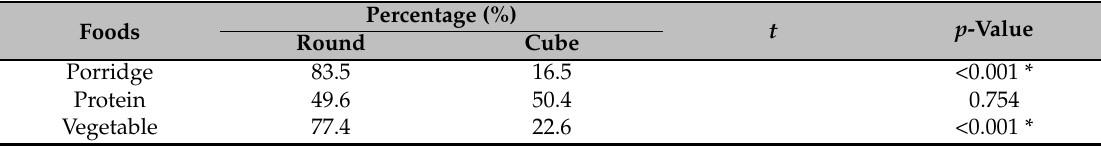
Table 12. Differences between foodscapes (shape) preference based on food type ( n = 133).